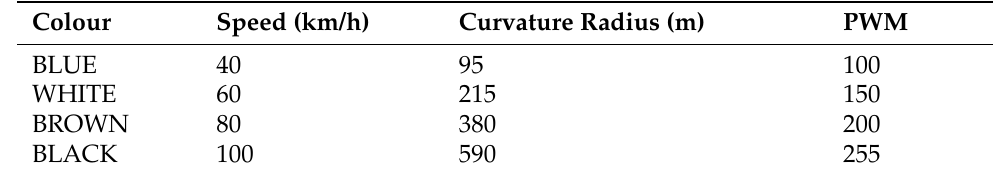
Table 1. Relationship between color, speed, curvature radius and PWM.